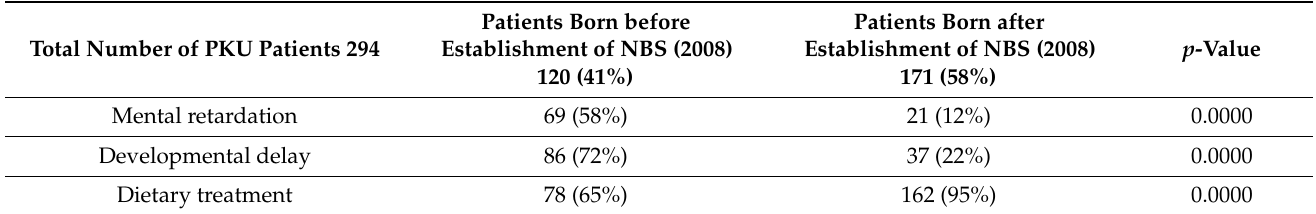
Table 3. Number and percentage of PKU cases identified since the 2008 establishment of the Newborn Screening Program (NBS) in Jordan.